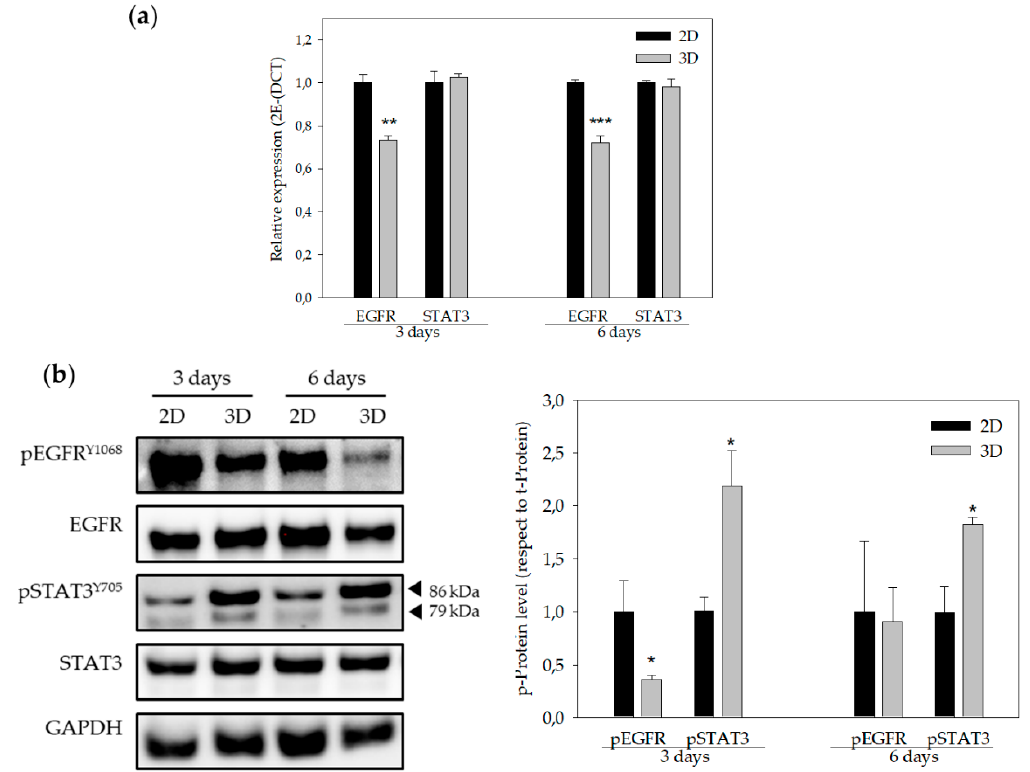
Figure 5. EGFR and STAT3 genes expression and protein levels. ( a ) EGFR and STAT3 gene expression of MDA-MB-231 cells cultured in 2D (black bars) and in 3D (grey bars) using 15% PLA scaffolds over three days (left) or six days (right). ( b ) Quantification of protein levels (EGFR and STAT3) obtained by Western blot analyses (right panel) of MDA-MB-231 cells cultured in 2D (black bars) and in 3D (grey bars) using 15% PLA sca ff olds over three days (left) or six days (right). Results are expressed as the ratio of activated protein (p-Protein) vs. total levels of protein (t-Protein). Experiments were performed at least three times. * ( p < 0.05) indicates levels of statistical significance. For an easier interpretation, the value obtained for cells cultured in 2D was adjusted to 1 and that of the 3D-cultured cells was calculated based on this.